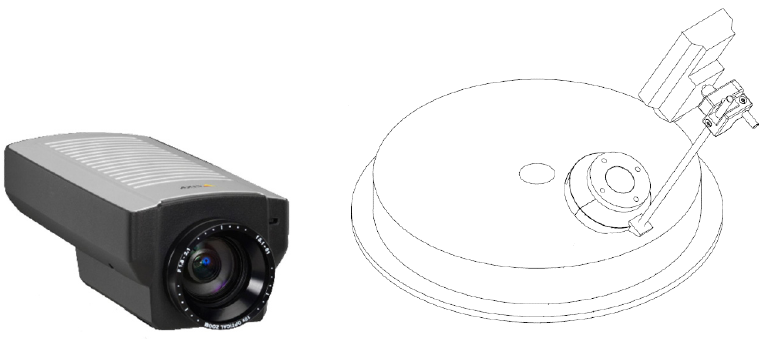
Figure 12. Camera system and a sketch of the mounting on the lid of the HPSR lab reactor.